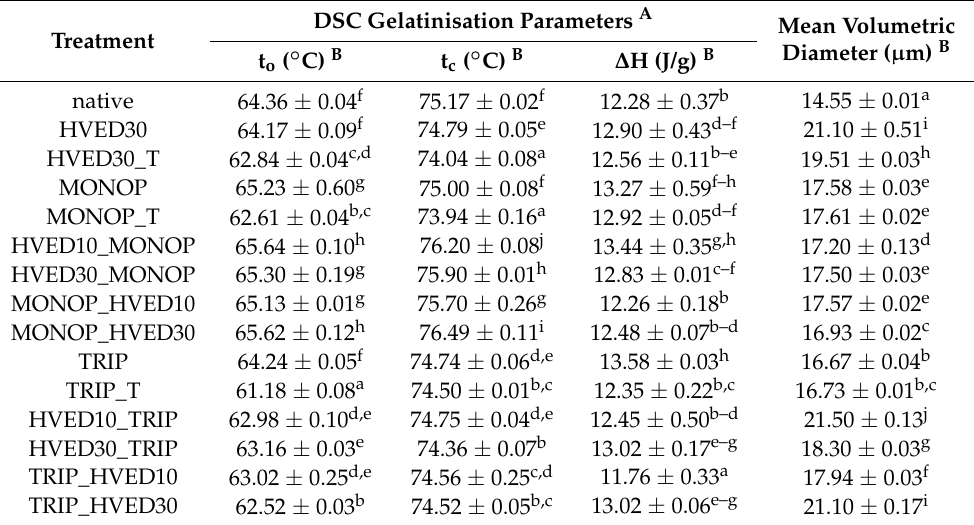
Table 2. Gelatinization parameters and mean volumetric diameter of native and modified maize starches (HVED10 = 10 min treatment with HVED; HVED30 = 30 min treatment with